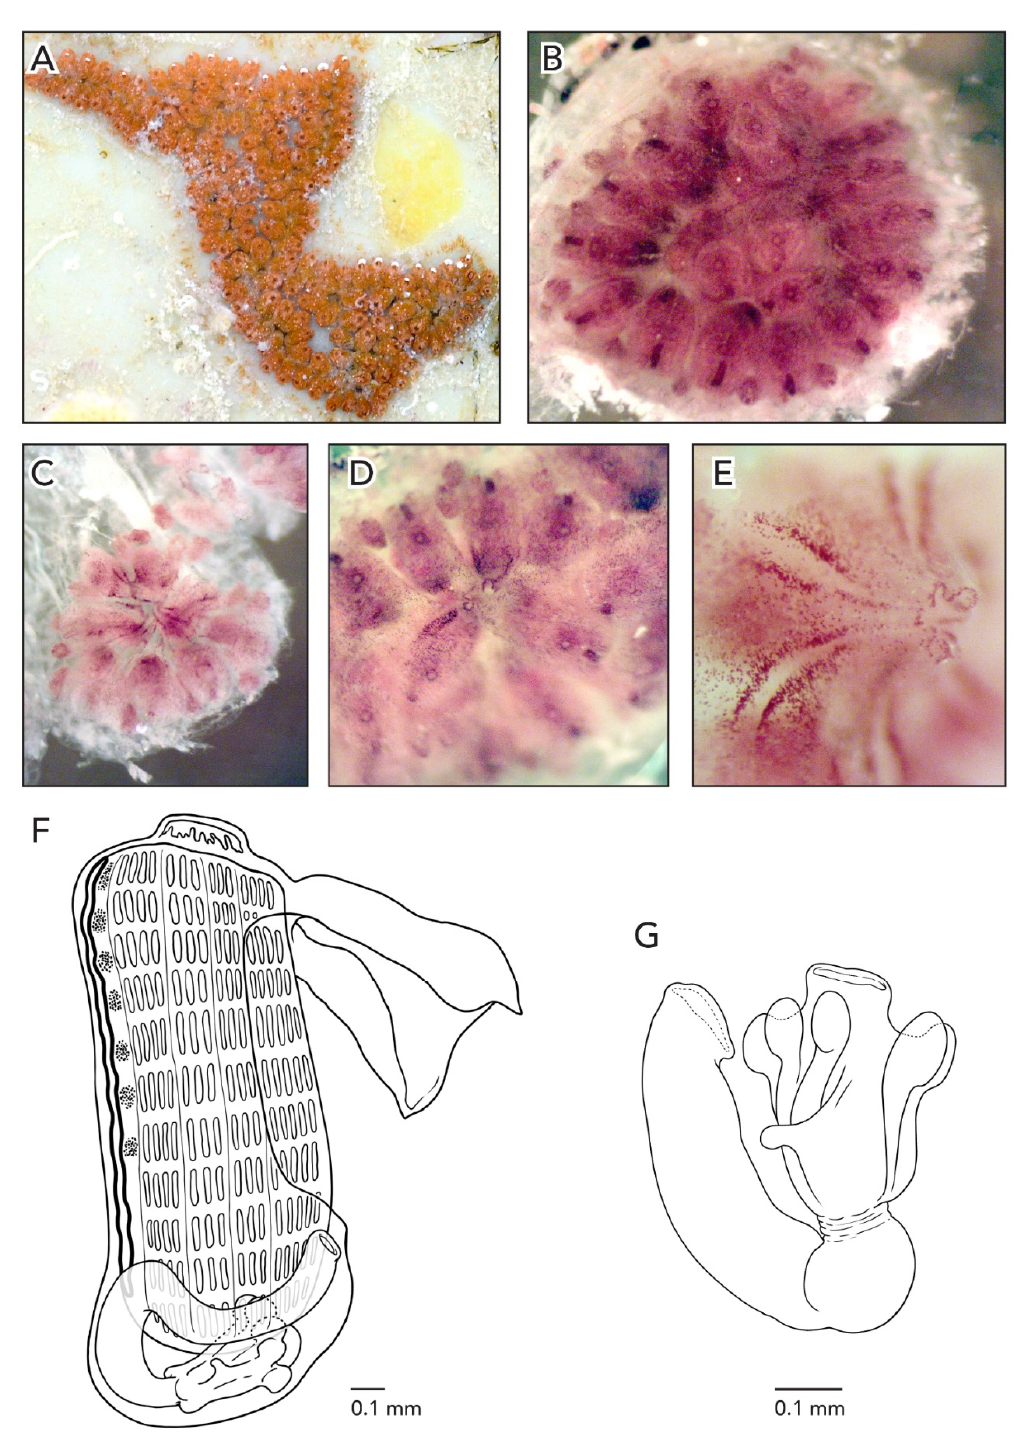
Botryllus hartensis sp. nov. (Figure 2, Figure 5 and Figure 17) Holotype: CAGoM-2087 , Bajo 10 Reef (ARMS), artificial substrate, 7 m depth, 30 April 2019, col. Lilian Palomino-Alvarez. Paratype: CAGoM-2093, Bajo 10 Reef (ARMS), artificial substrate, 7 m depth, 30 April 2019, col. Lilian Palomino-Alvarez.